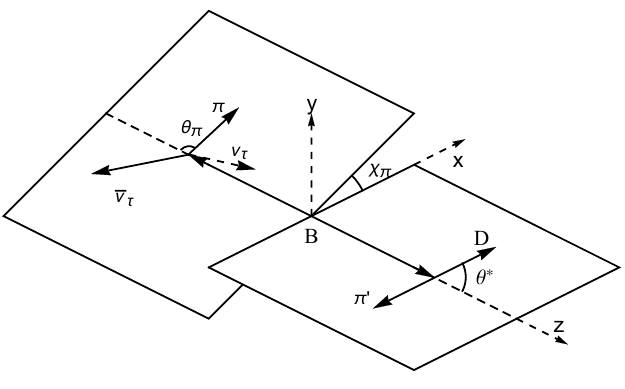
Figure 2 . De(cid:12)nition of the angles in the (cid:22) B ! D (cid:3) ( ! D(cid:25) ) (cid:28) (cid:0) ( ! (cid:25) (cid:0) (cid:23) (cid:28) )(cid:22) (cid:23) (cid:28)